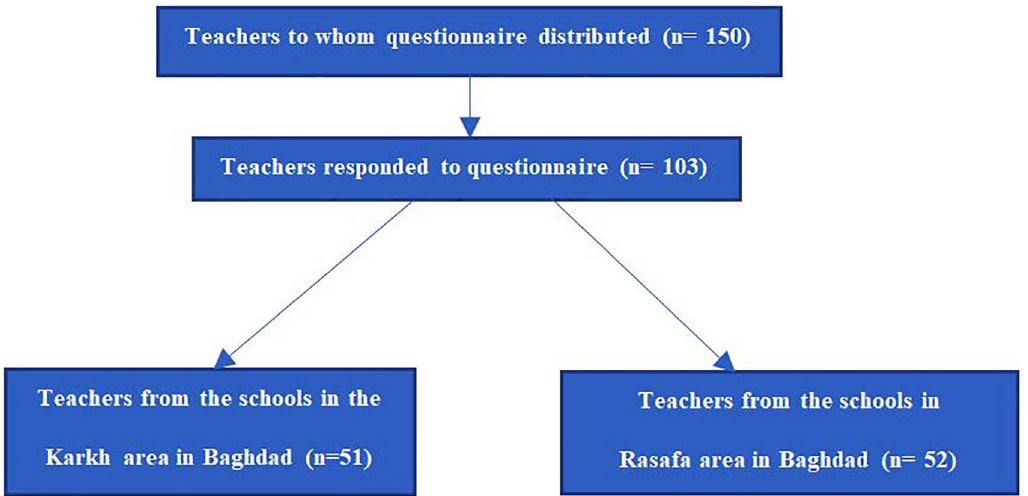
Figure 1. Summary of the number of participants involved in the study of statistical analysis from invitation, responses, and geographical region of Baghdad.